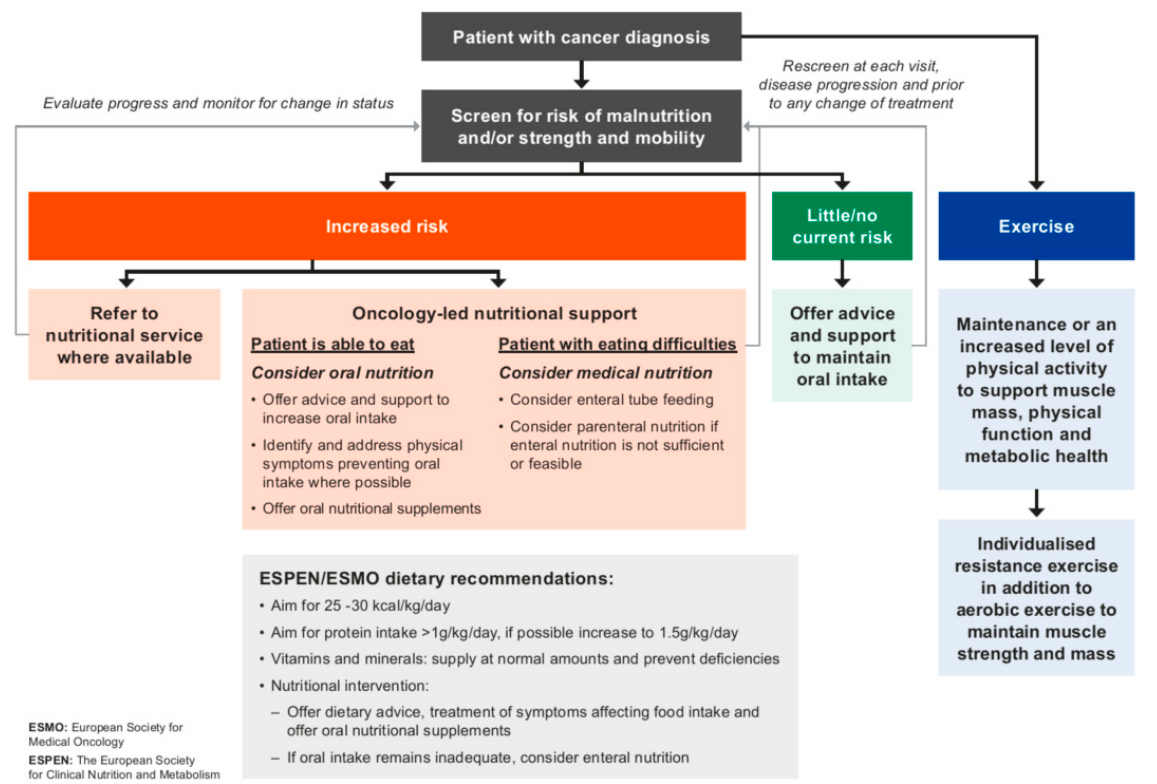
Figure 2. Decision-making algorithm following screening for the risk of malnutrition/loss of muscle mass in patients with a diagnosis of cancer, should no dedicated nutrition service be available. Content adapted and developed from ESMO and ESPEN evidence-based guidelines [30,45].